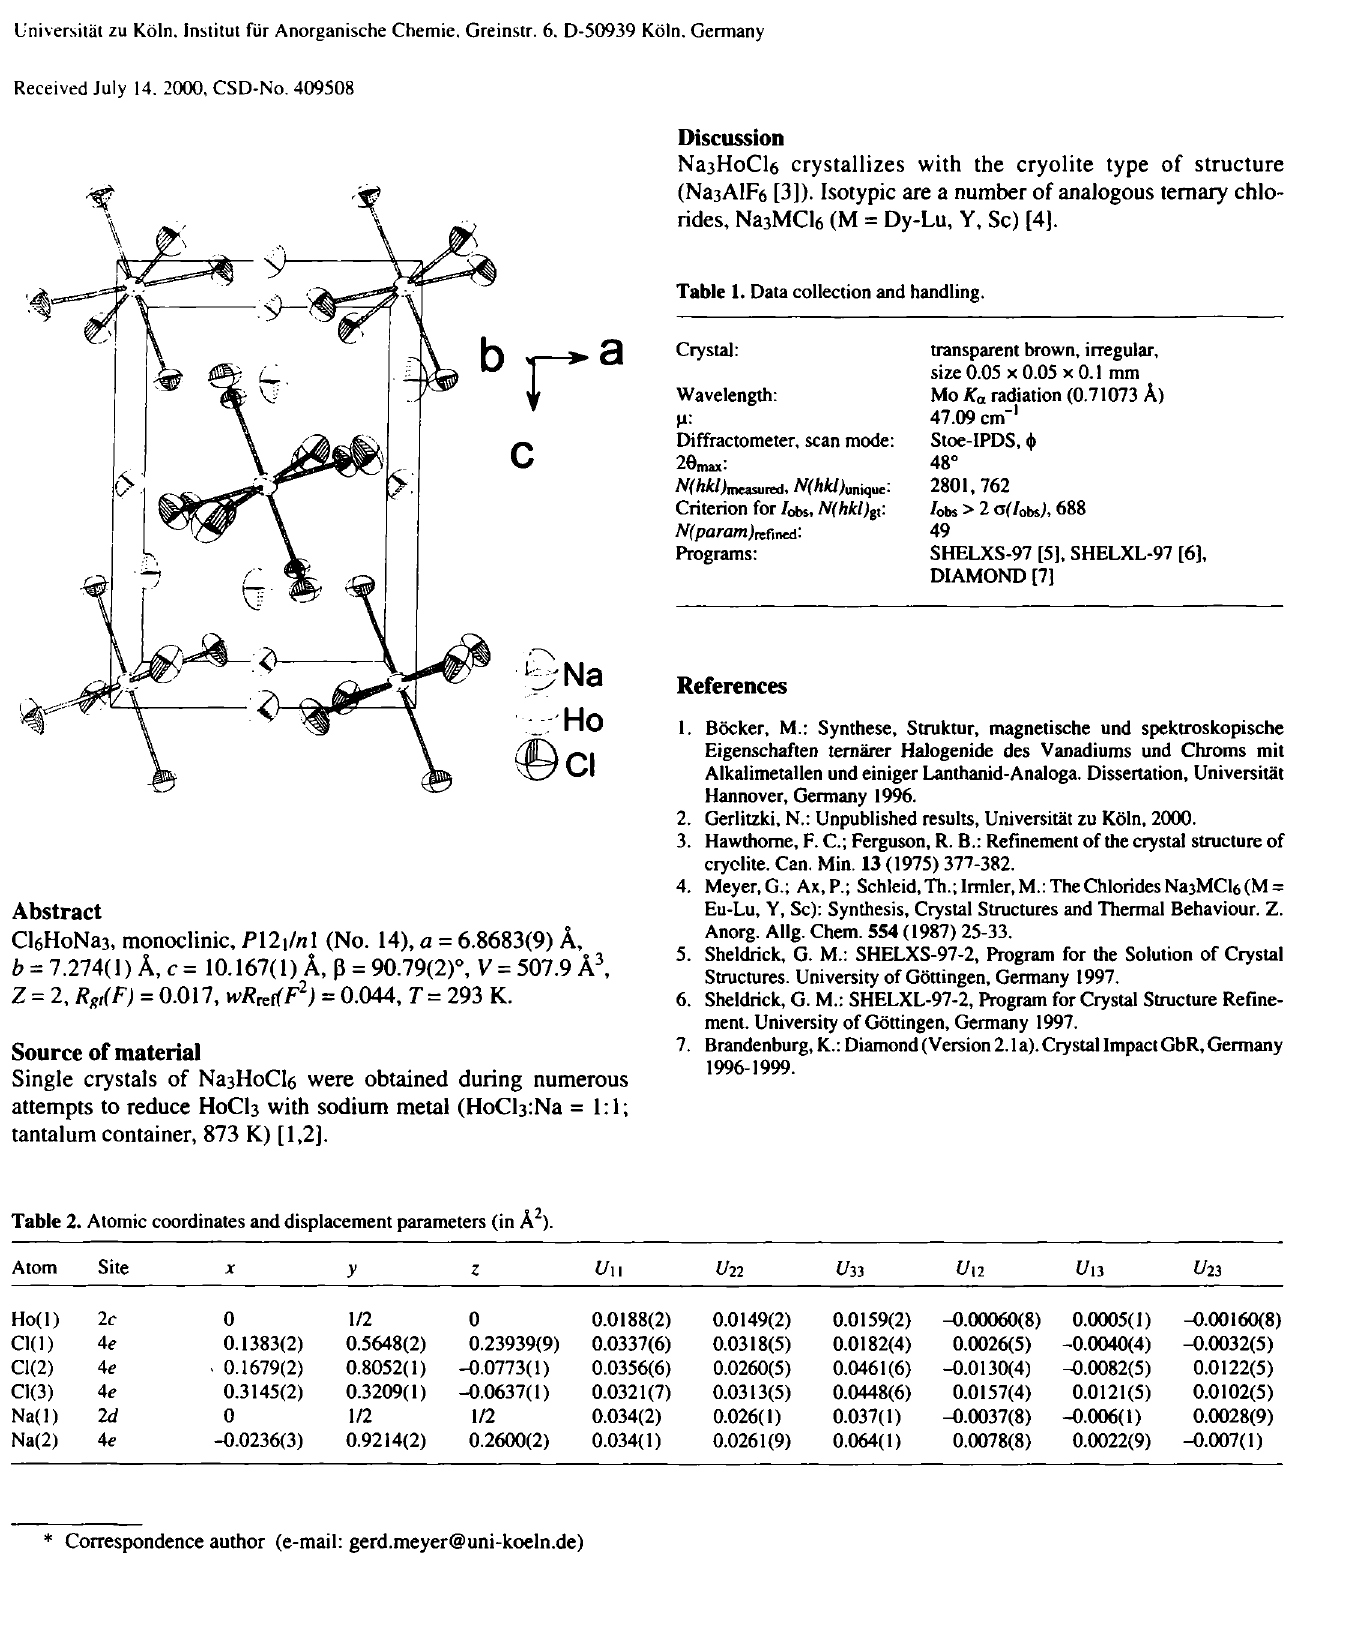
Na3HoCl6 crystallizes with the cryolite type of structure